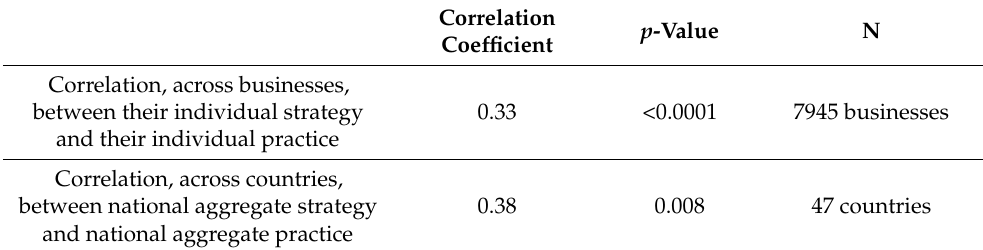
Table 6. Correlations between strategy and practice, across businesses and across countries. Correlation